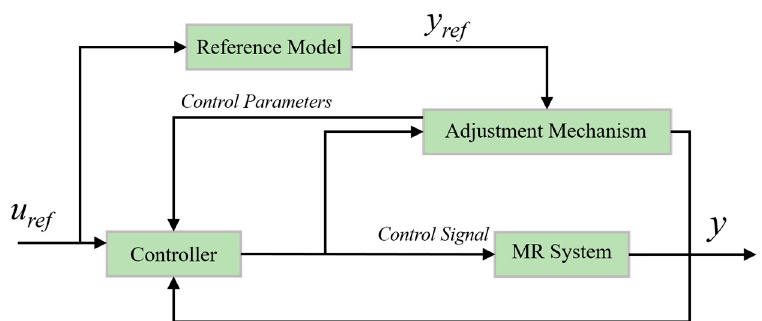
Figure 9. Model reference of an adaptive control system block diagram [26]. Reproduced with permission from Choi, S.-B. et al. State of the art of control schemes for smart systems featuring magnetorheological materials; published by Smart Materials and Structures, 2016. Table 1. Vibration control strategies using magnetorheological materials actuators: application per ‐ spective.